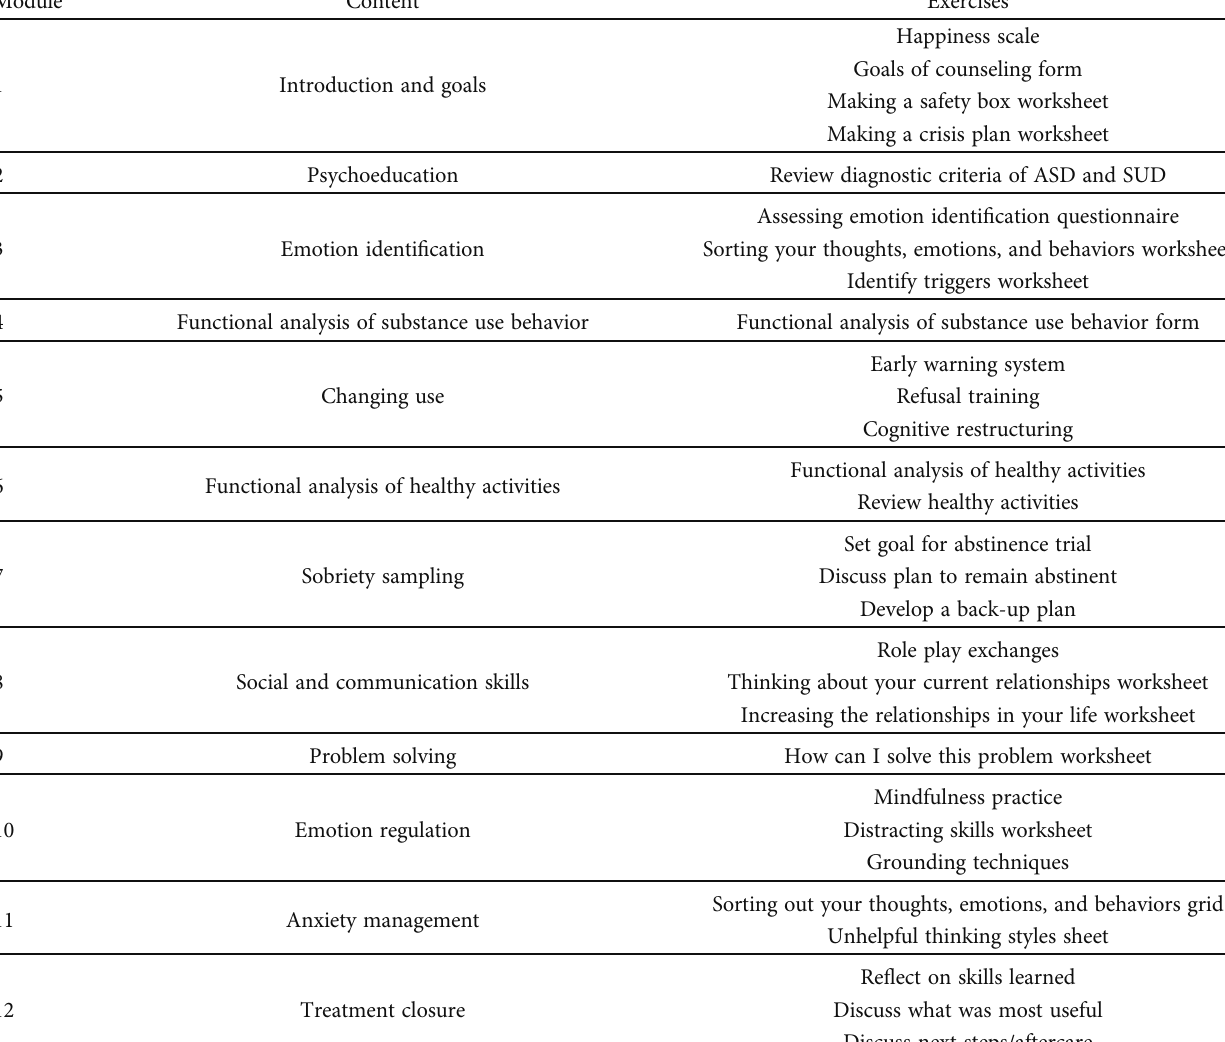
Table 1: Protocol content of youth modules for youth with autism spectrum disorder (ASD) and substance use disorder (SUD).